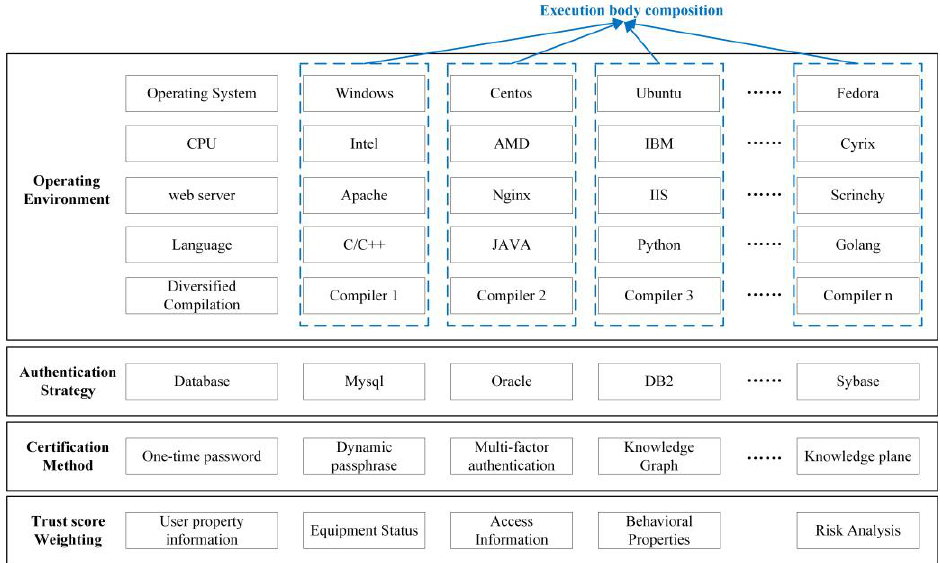
Figure 3. Heterogeneous access control engine.